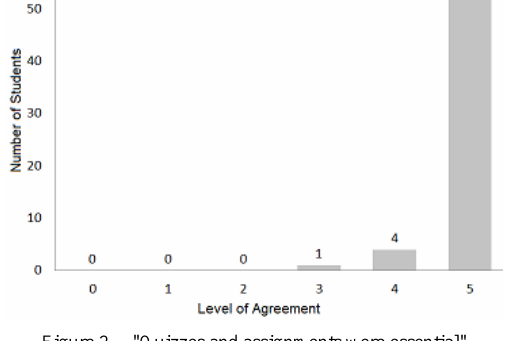
Figure 6. "The video lectures need to be recorded and posted"